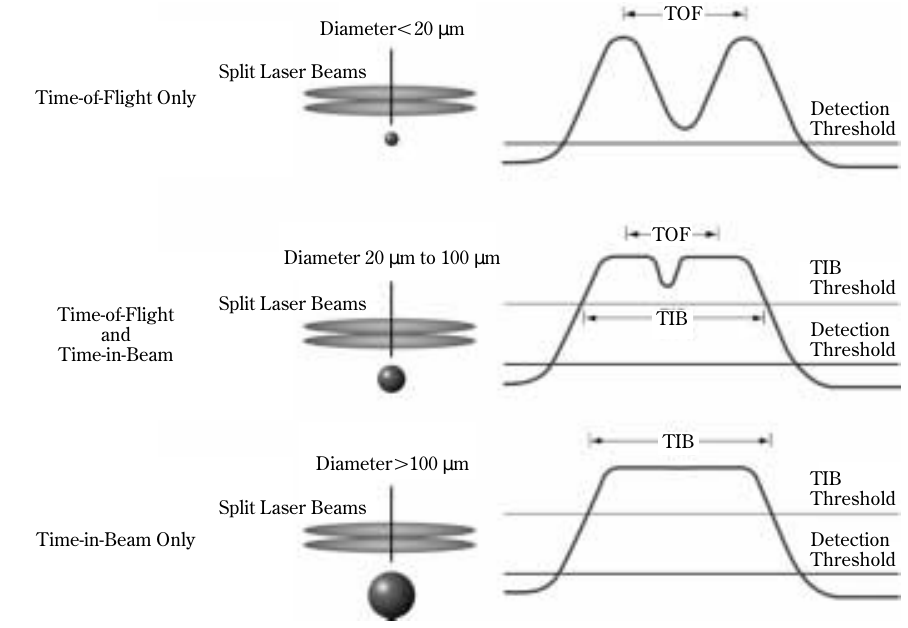
Fig. 8 ‘Double-crest’ particle detection system utilized by models 3320 and 3321 of the APS ® aerodynamic particle sizer spectrometer (cour- tesy